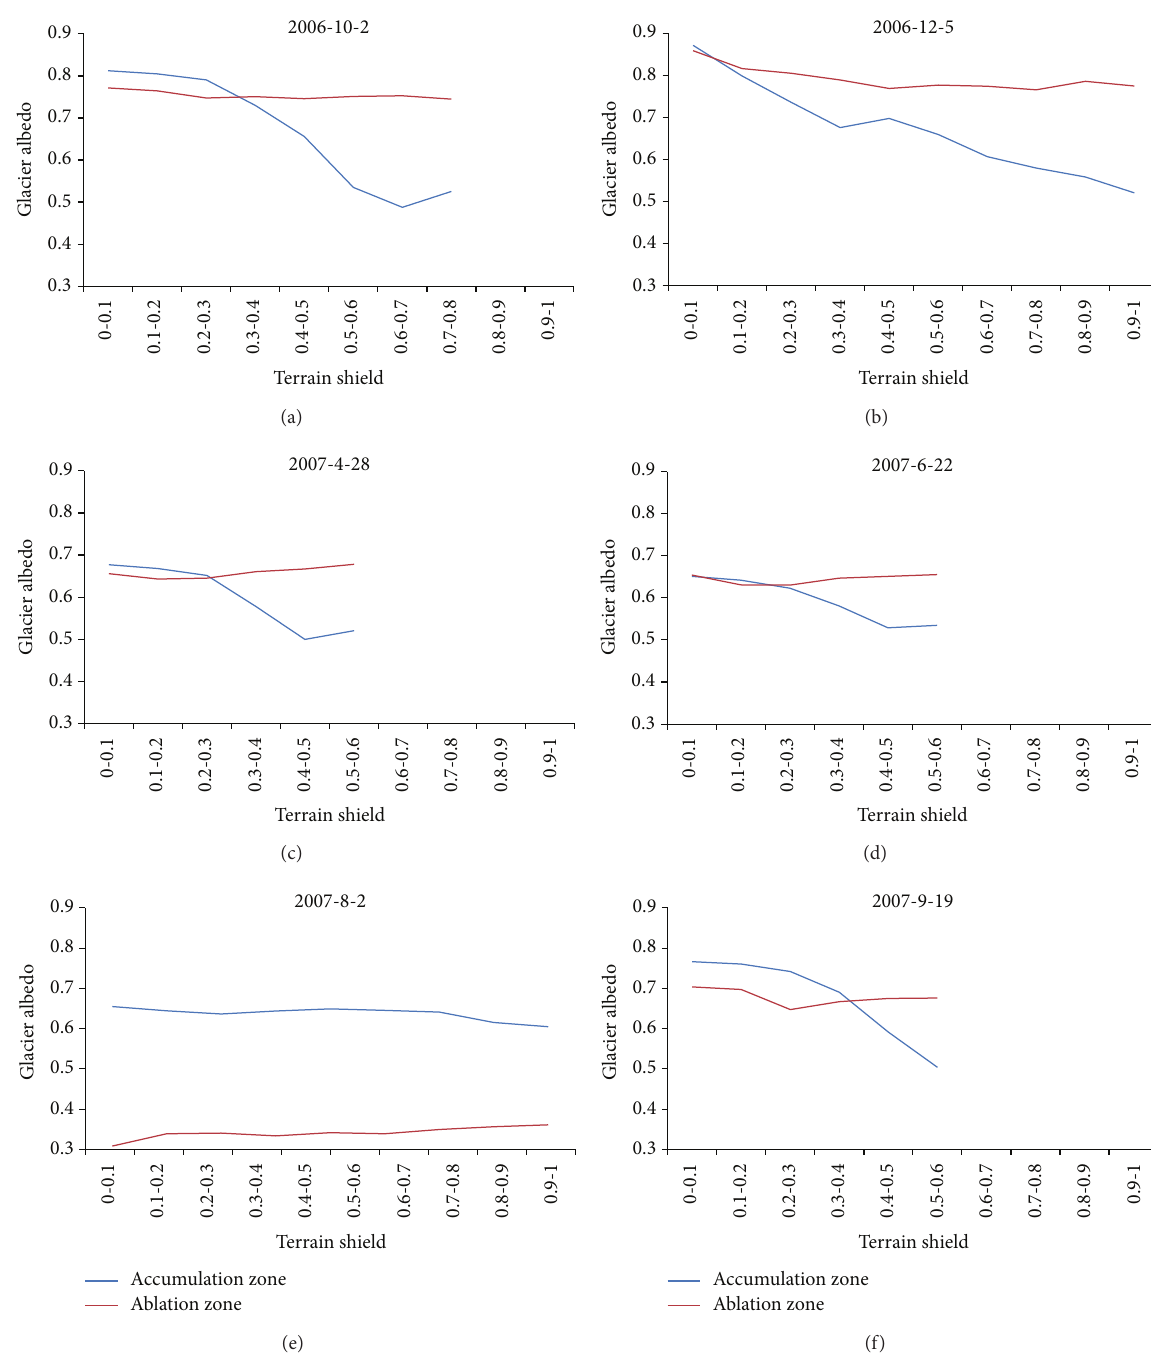
Figure 6: Albedo variations with terrain shield for the accumulation zone and ablation zone on the different months in 2006-2007.